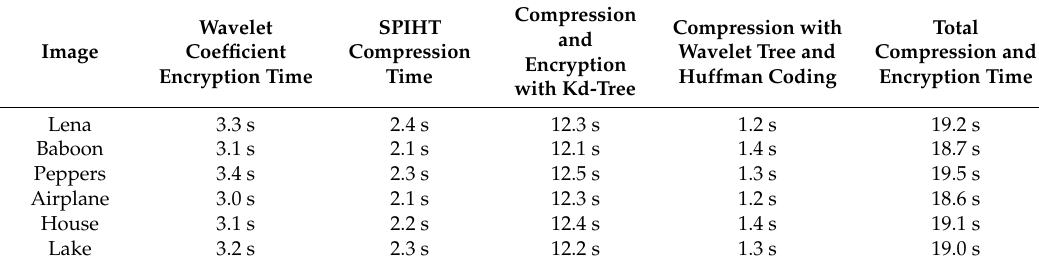
Table 11. Compression and Encryption